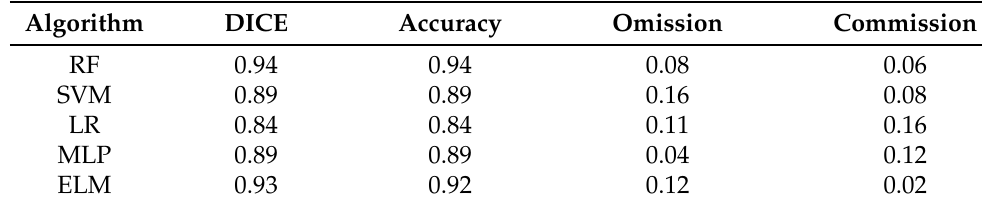
Table 5. Best model performance over the DELTA dataset for the validation set.